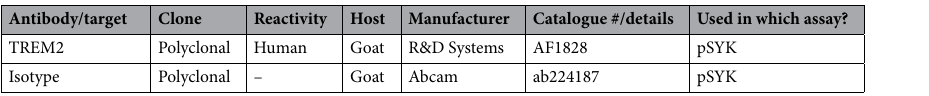
Table 2. TREM2-specific and control